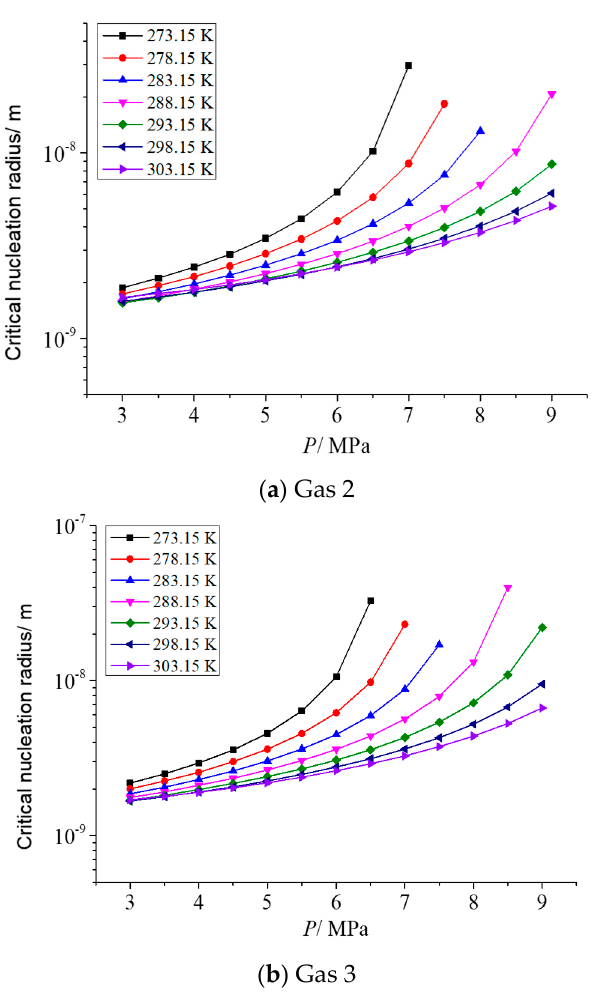
Figure 2. Curve of critical nucleation radius changing with pressure. Table 4. Calculation results of critical nucleation radius of elemental sulfur in gas